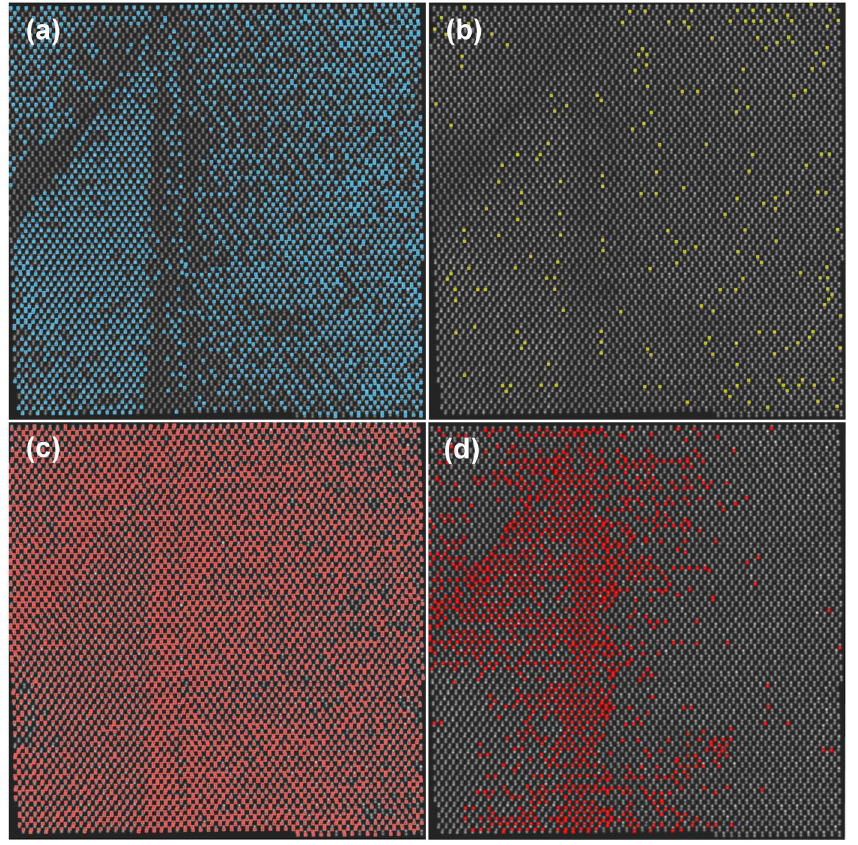
Figure 3. SCS mappings of the HAADF image in Fig. 2(a), with different SCS regions indicated in the histogram in Fig. 2(b). ( a ) Distribution of atomic-columns with SCS that are greater than ( > ) 5.4 e − Å 2 , which selects Bi-containing columns. ( b ) The distribution of SCS > 6.8 e − Å 2 , indicating columns with the highest Bi- content. ( c ) SCS < 4.7 e − Å 2 , which mainly selects Ga columns, and also the weaker scattering group-V columns where outlined. ( d ) SCS < 3.9 e − Å 2 , shows the distribution of Ga columns with low SCS values, and very weakly scattering group-V